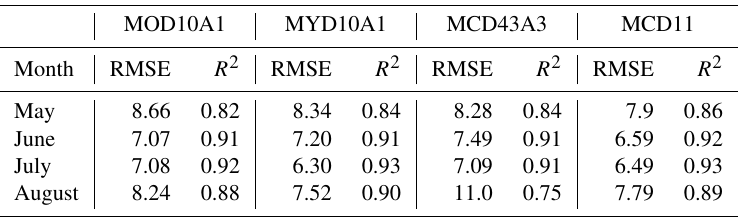
Table 2. Comparison of MODIS albedo products (MOD10A1, MYD10A1, MCD43A1, and MCD11) with GAWS in situ albedo on a monthly